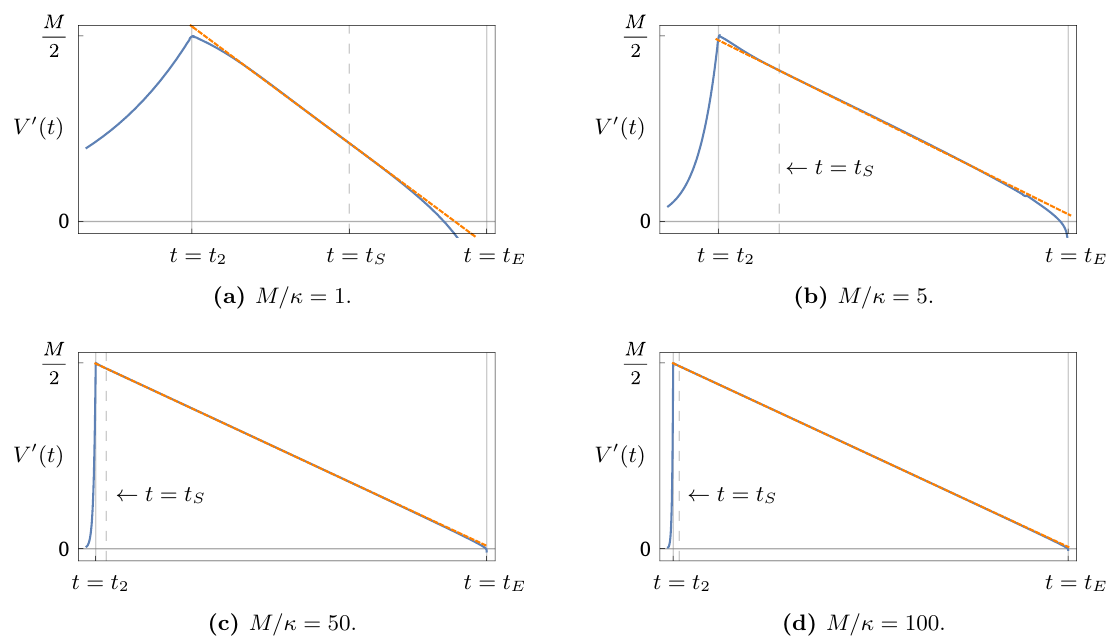
Figure 5 . Numerical results of volume growth for di(cid:11)erent values of M=(cid:20) . The black hole creation time is indicated by t = t 2 while the evaporation process is completed at time t = t E . The blue curve depicts the numerical result while the dashed orange line is obtained by a linear extrapolation of the curve around the scrambling time t S